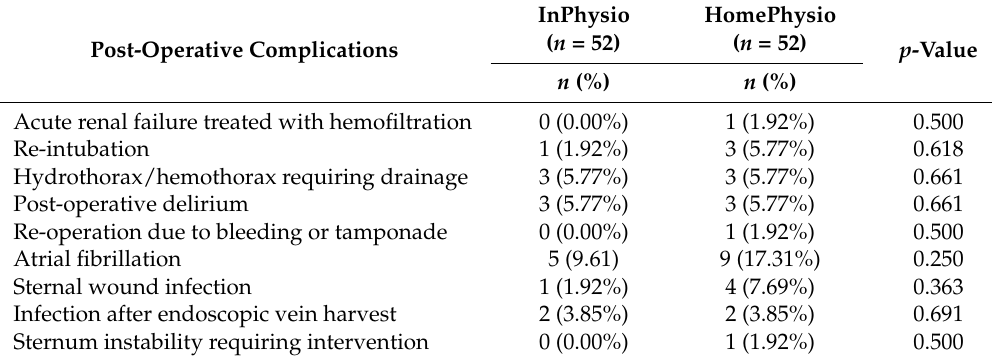
Table 2. A list of post-operative complications in both